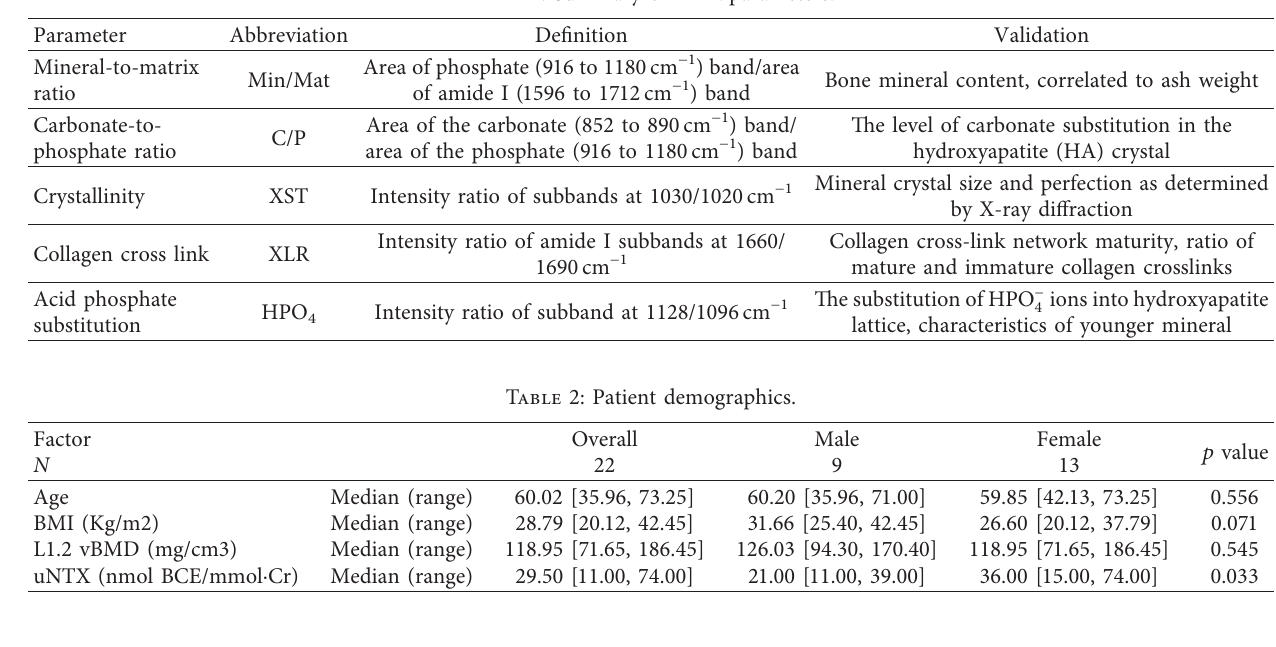
Table 3: Distribution of FTIR